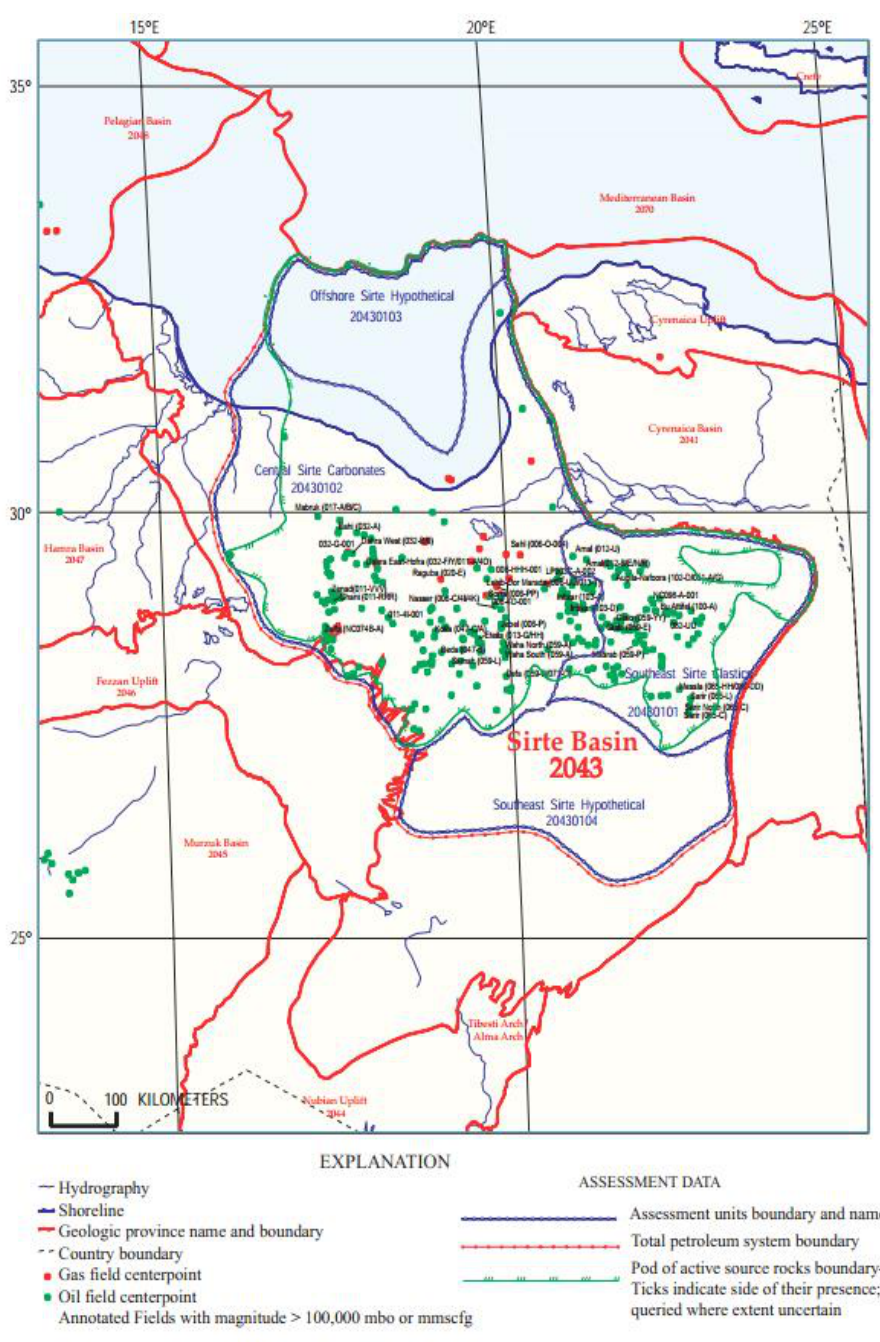
Figure 1. The Sirte Basin is a Libyan oilfield